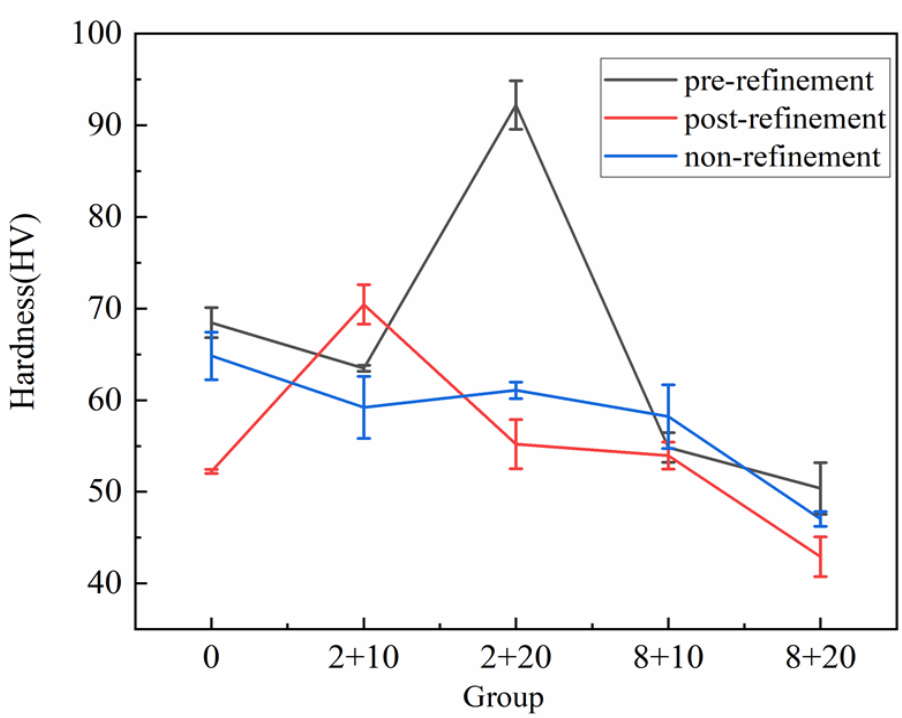
Figure 9. Hardness curves of “pre-refinement”, “post-refinement”, and “non-refinement” hypoeutectic Al-10Si-0.48Mg alloys with different heat-treatment methods.